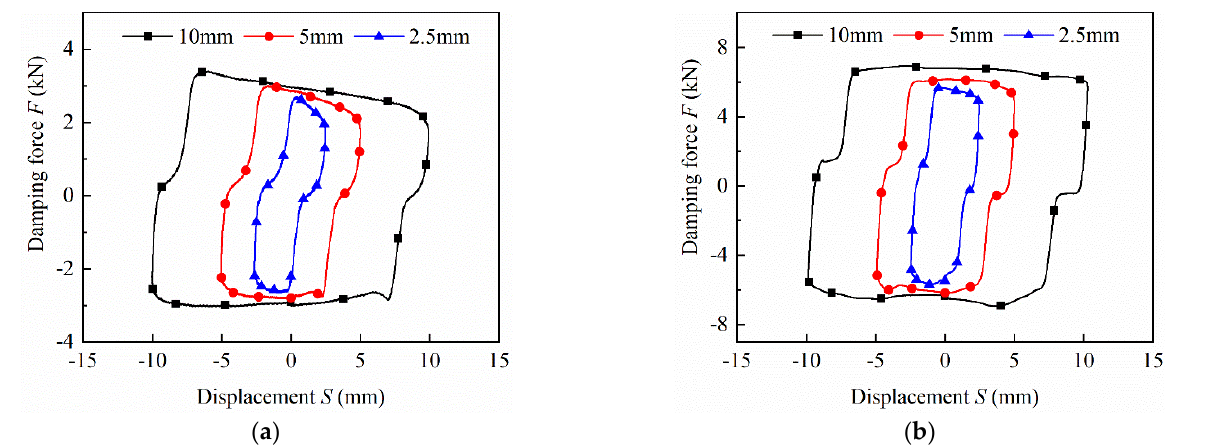
Figure 16. Damping force under different amplitudes: ( a ) initial; ( b ) optimal.